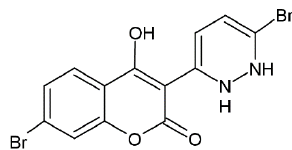
Figure 16. Chemical structure of 7-bromo-3-(6-bromopyridazine-3yl) coumarin.